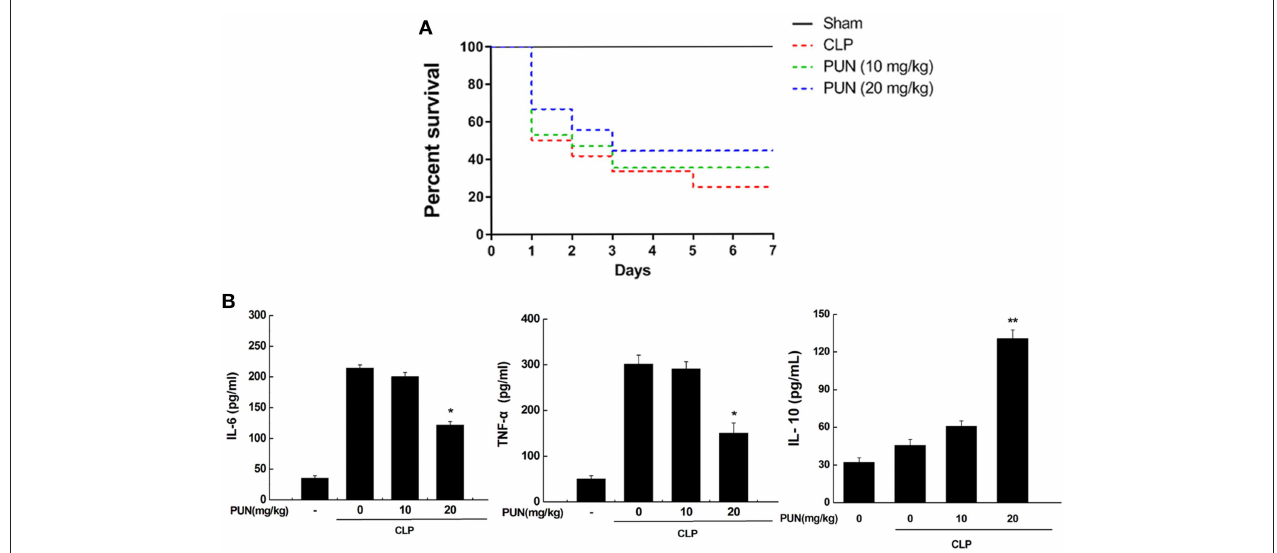
FIGURE 6 | PUN treatment prevents sepsis-induced excessive inflammation in mice. (A) Kaplan–Meier curves for the survival rate of septic mice. Eighty mice were involved in the comparison. The dosages of PUN used in this study were indicated as 0, 10, and 20 mg/kg · bw, respectively. PUN was orally administrated at the indicated dosage 3 days ahead of CLP surgery. Then all mice had surgery with or without cecal ligation and puncture. The observation for mortality continued for 7 days. (B) ELISA detection on expression of serum cytokines (24h after surgery). Data are expressed as mean ± SD of three independent experiments. * p < 0.05 indicates statistically significant differences as compared with the CLP surgery group. ** p < 0.01 indicates statistically significant differences compared with LPS